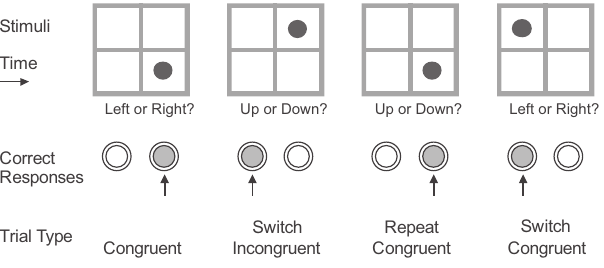
Means ± standard deviations for all data except the numbers of subjects. NART-R is National Adult Reading Test Revised. Signifi cant Asterisks show differences from CTL.